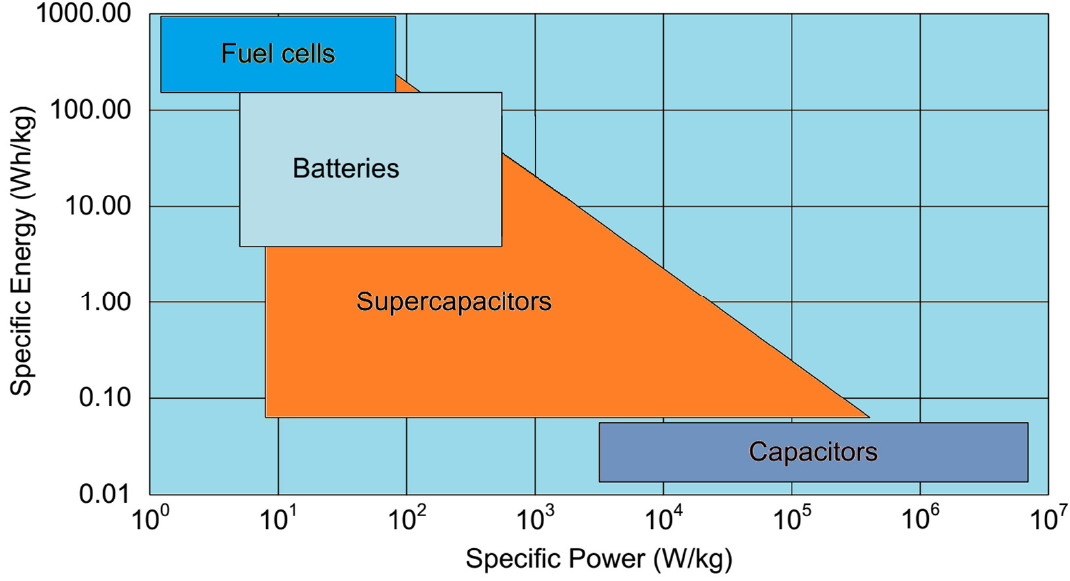
Figure 12. Comparison between energy sources [38].